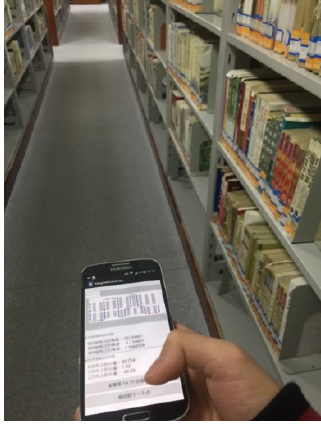
Figure5 Data collection process